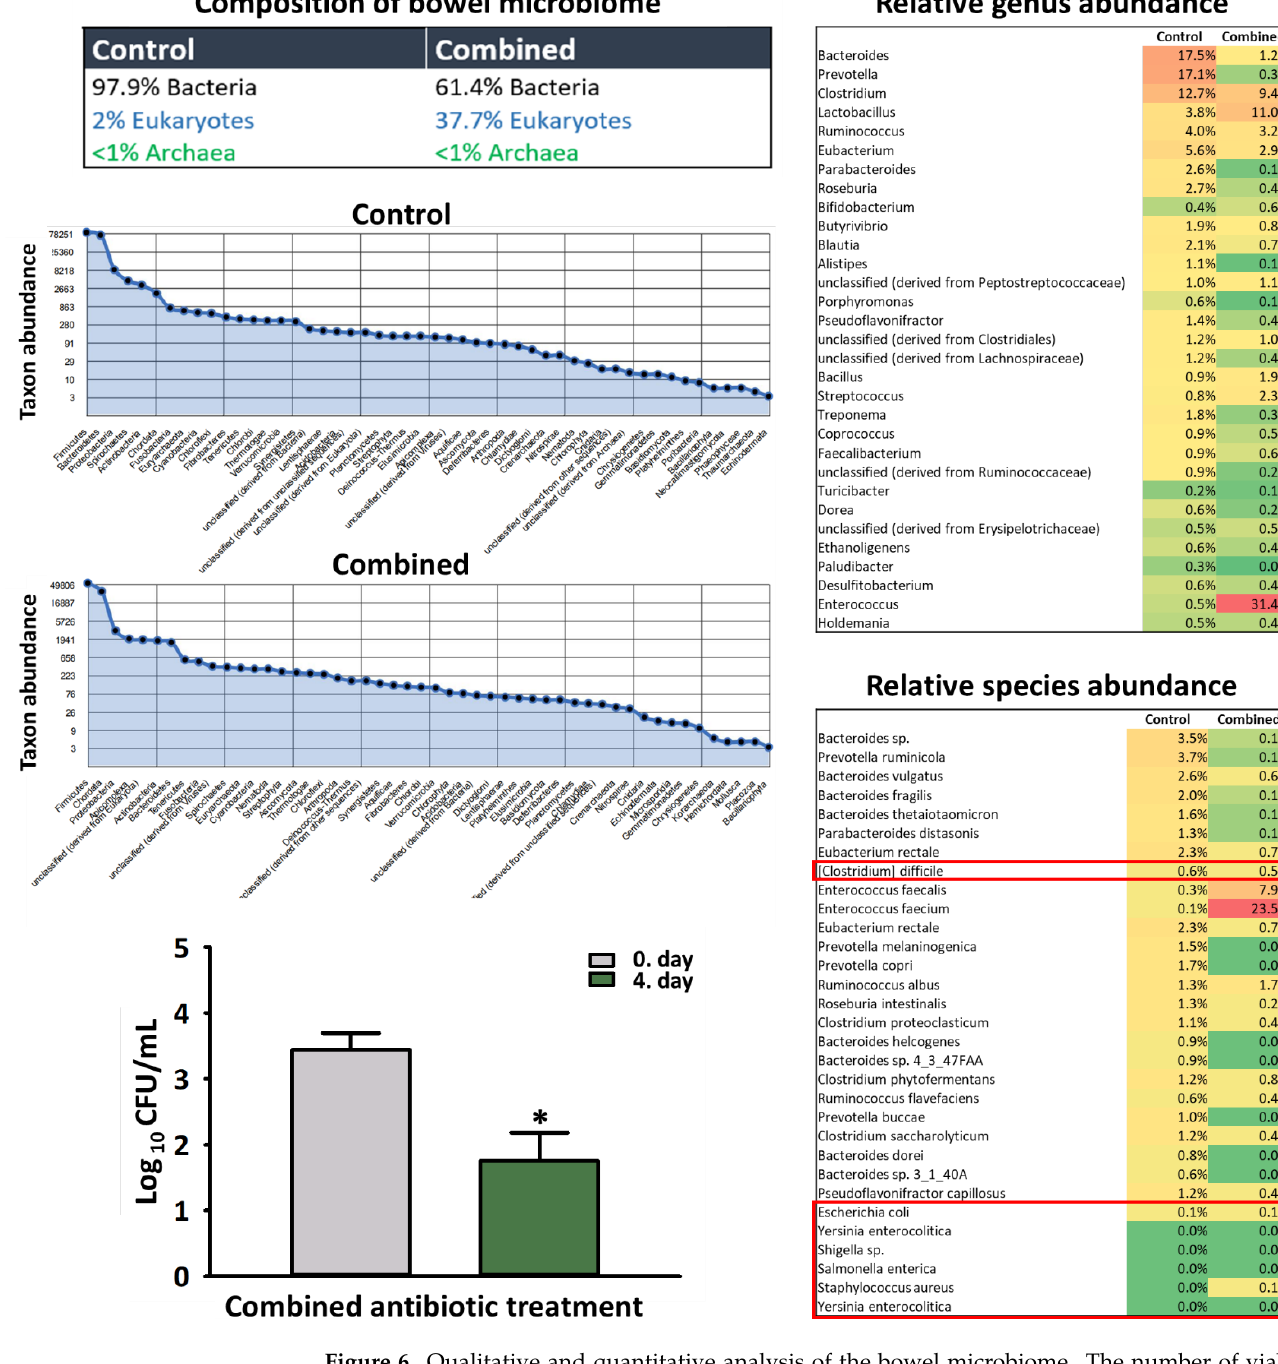
Figure 6. Qualitative and quantitative analysis of the bowel microbiome. The number of viable anaerobic bacteria was reduced with 2 orders of magnitude after 3-day-long antibiotic pretreatment (expressed as Log 10 CFU/mL). Diversity and abundance of the bowel microbiome have changed in response to combined antibiotic treatment. Metagenomic sequencing did not indicate the overgrowth of toxin-producing bacteria such as C. difficile , E. coli , K. oxytoca , Y. enterocolitica , S. aureus , S. enterica and Shigellae. Black column: Day 0 (before treatment); Gray columns: 4th day (after combined treatment). Data are presented as mean ± SEM. * p < 0.05 vs. control (one-way ANOVA, Holm–Sidak test) are considered as significant.